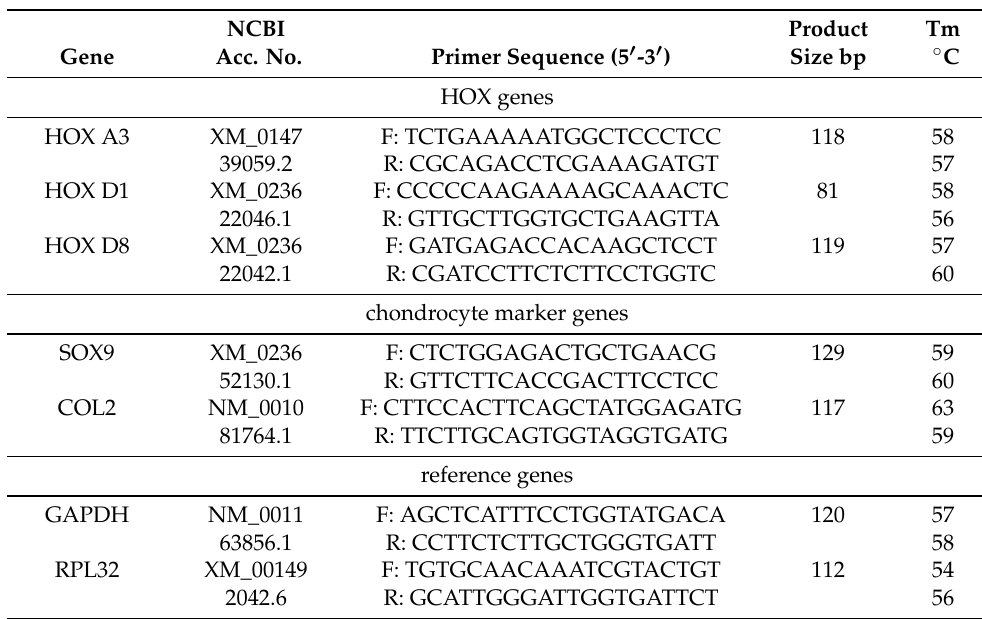
Table 1. List of used